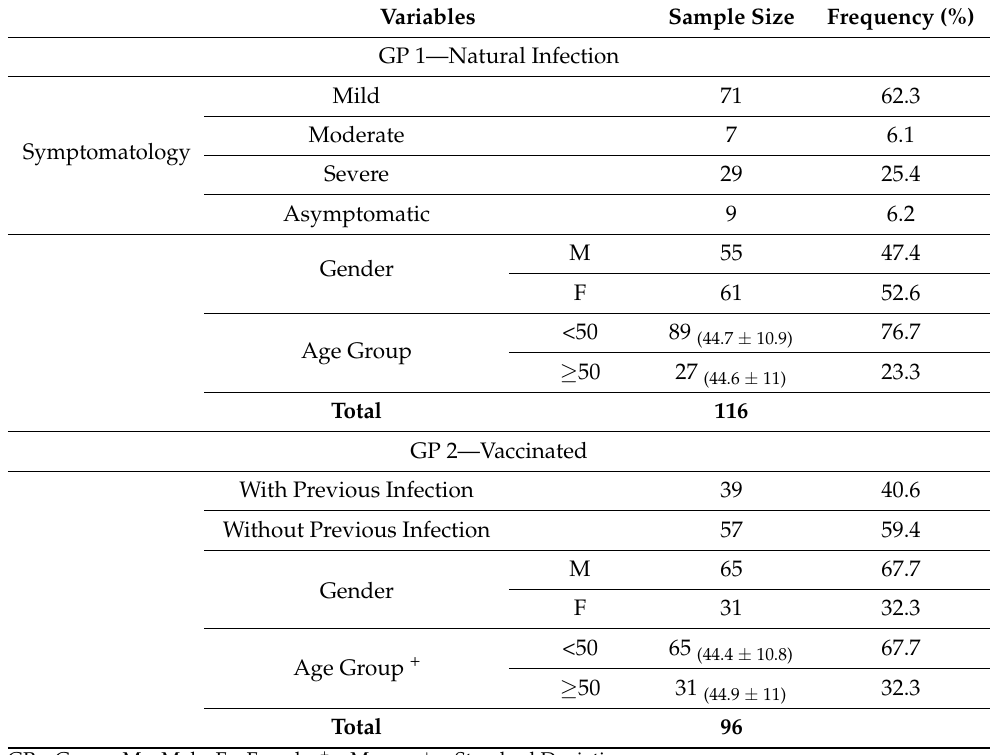
Table 1. Participant